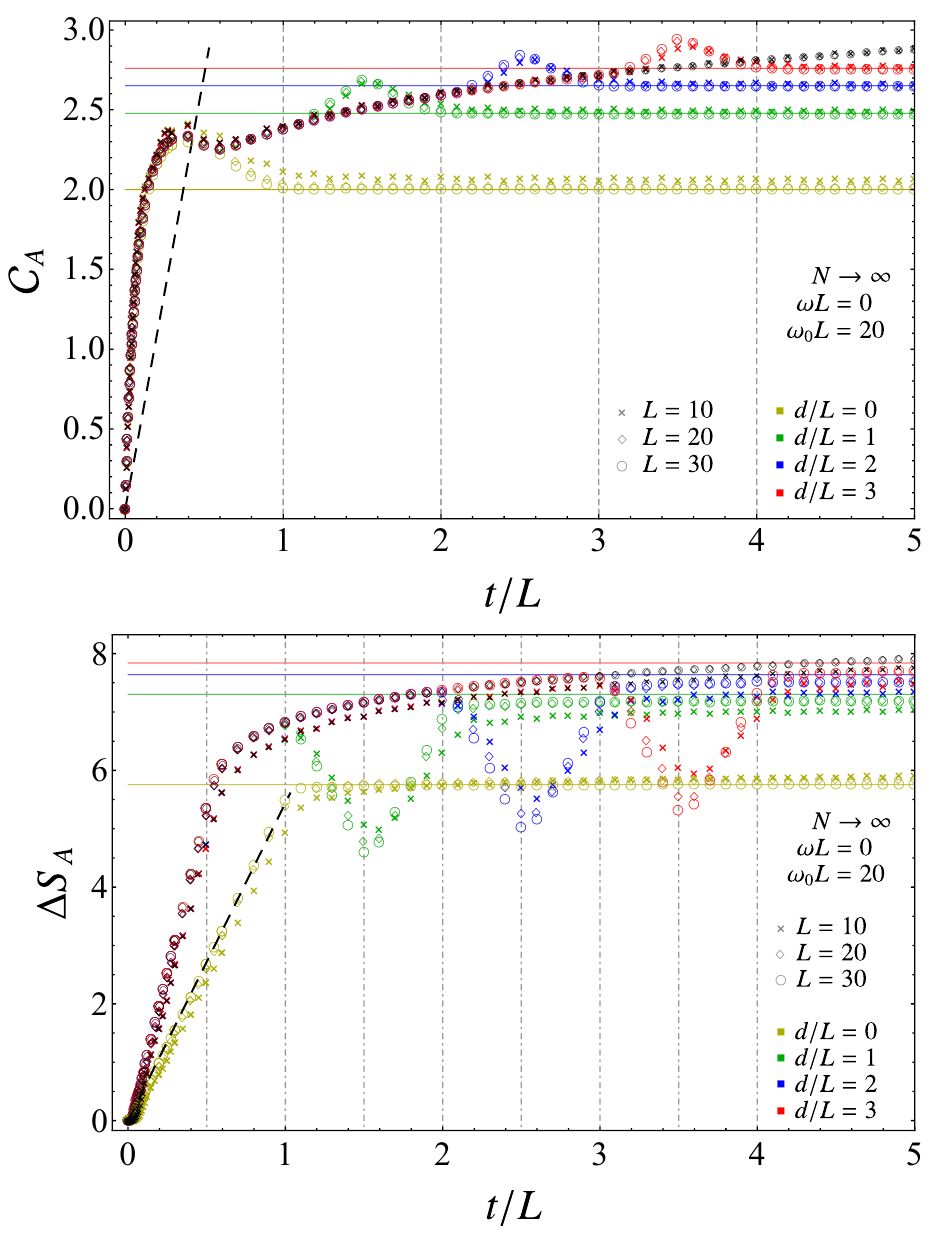
Figure 14 . Temporal evolution of C A (top panel) and of ∆ S A (bottom panel) after a global quantum quench with a gapless evolution Hamiltonian and ω 0 L = 20 . The subsystem is a block A made by L consecutive sites either on the infinite line (black data points) or on the semi-infinite line, separated by d sites from the origin where DBC hold (coloured data points). The dashed black straight line is the same in both